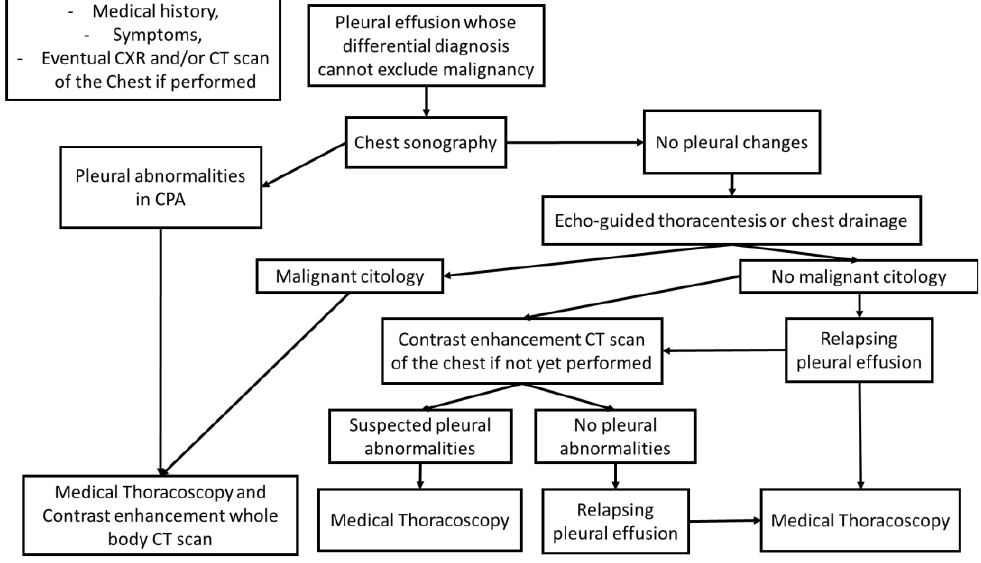
Figure 4. Proposal of diagnostic algorithm.